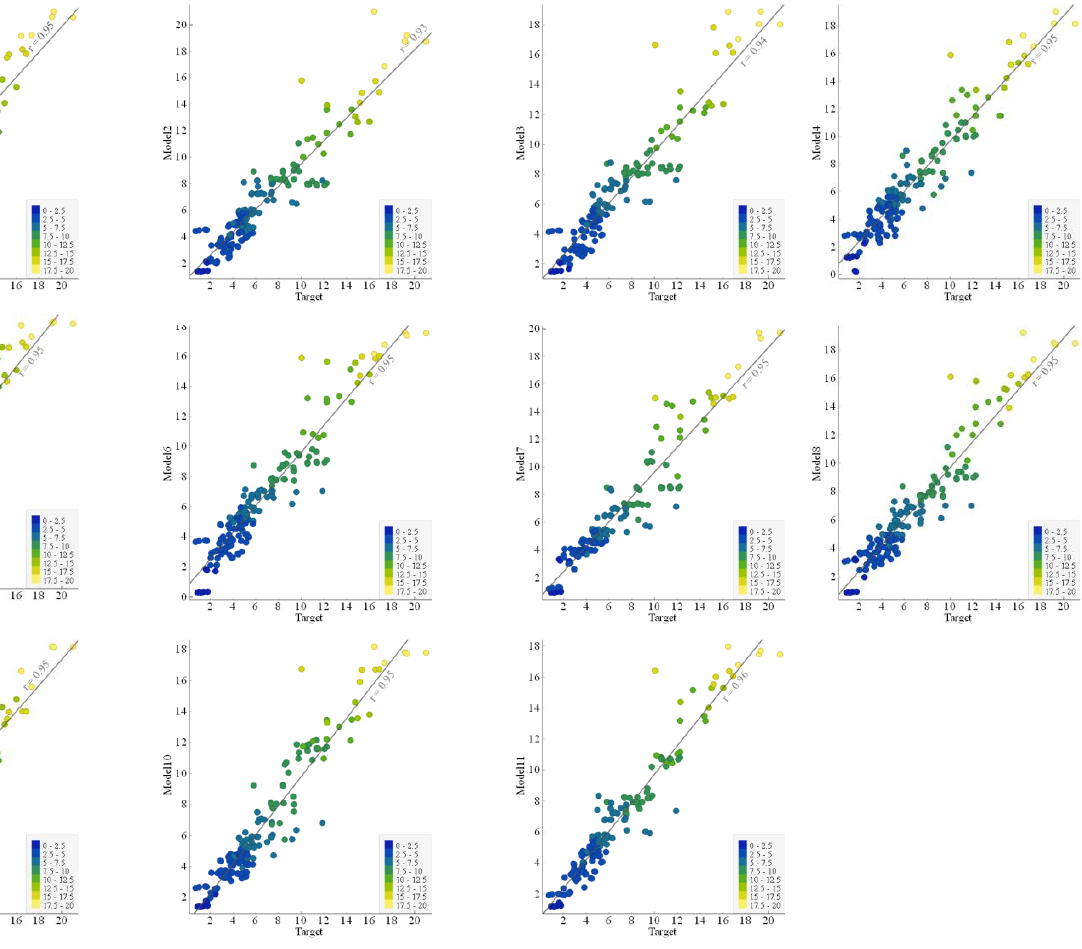
Figure 8. Comparison of the regression slope between experimental and predicted results for the training data.